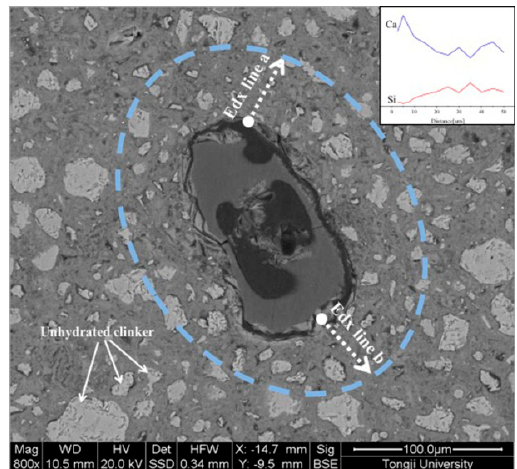
Figure 2. EDX line analysis of CPCA2-SAPs (the insert is the spectrum of EDX line referring to the corresponding element concentration).